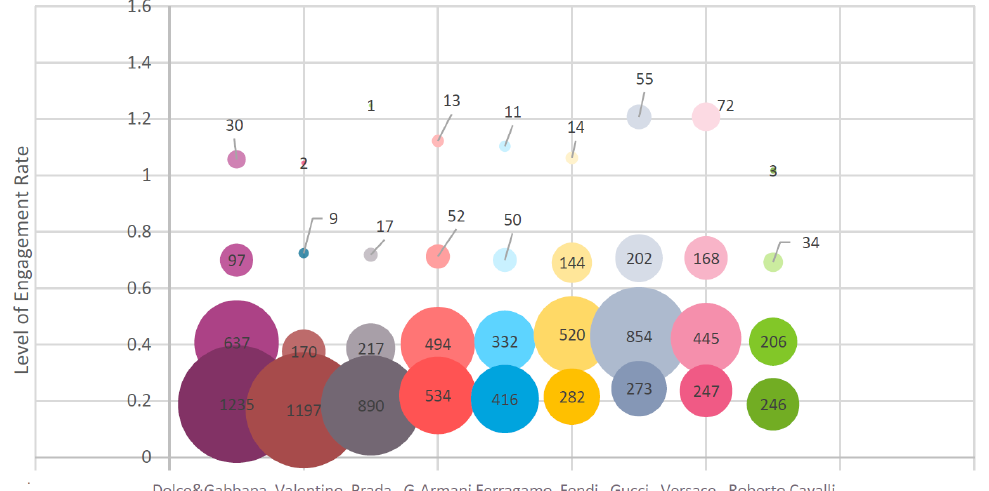
Figure 8. Normalized engagement rate for each brand discretized in different spectra as high , mid-high , mid-low and low